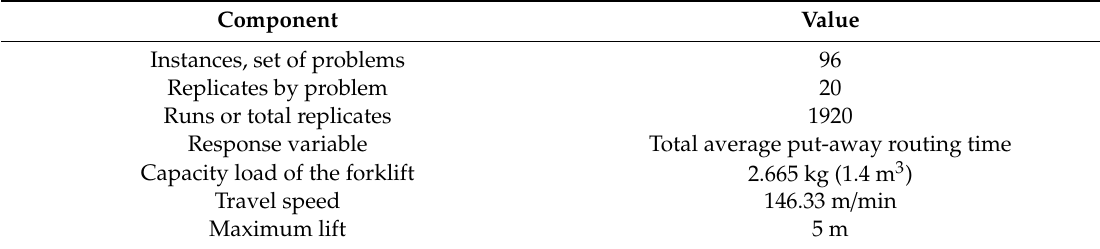
Table 1. Experimental study for PRP.